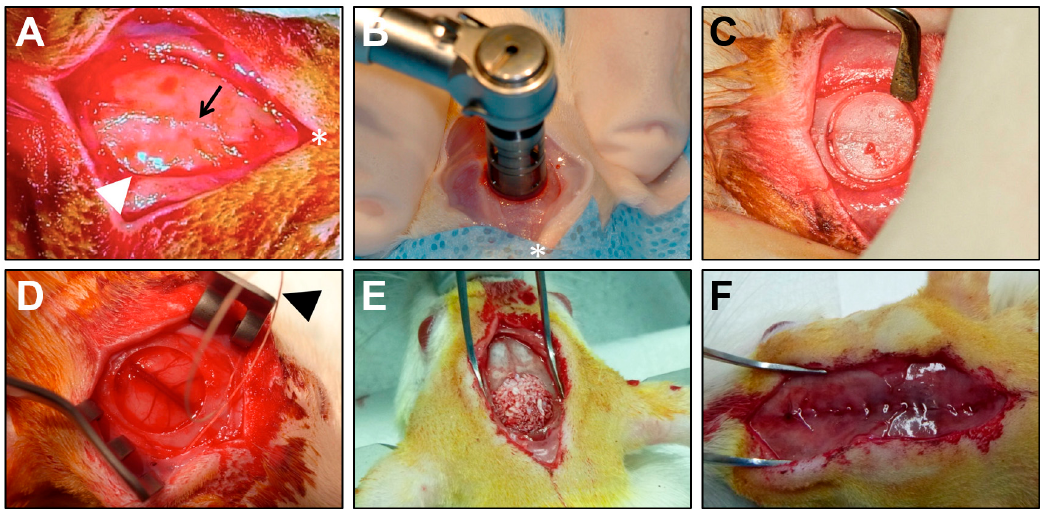
Figure 4. Representative images demonstrating the implantation of HA into the critical-sized (8 mm diameter) rat calvarial defect. ( A ) Access to the calvarial bones; ( B ) excision of the calvarial bones using a trephine; ( C ) calvarial bones ready to be excised; ( D ) calvarial defect upon the excision of the respective bone tissue; ( E ) filling of the calvarial defect with HA; and ( F ) closure of the periosteum over the implant.